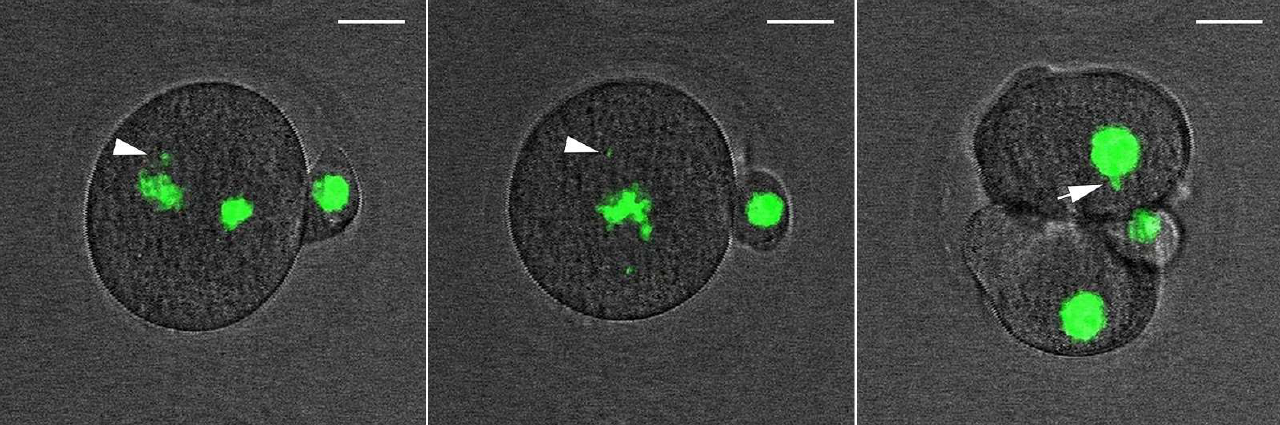
Figure 7. Still images form a time-lapse recording of one-cell mouse embryo expressing H2B-GFP during the first mitosis. The misalignment of chromatin is visible before the cleavage process (arrowheads) as is a micronuclear body in one blastomere of a two-cell embryo (arrow). Additionally, see Movie S1 in the Supplementary Data. Scale bar = 20µm.